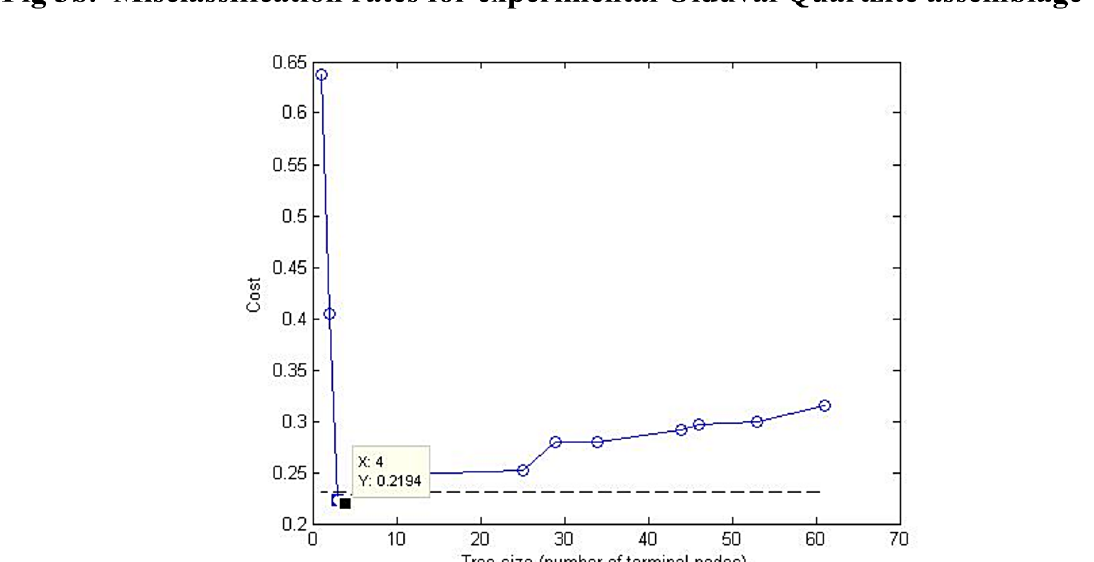
Fig 3. Trimming the classification tree. Each misclassification graph is constructed via random substitution of samples with empirically known classes into the trained algorithm. The X value represents the number of terminal nodes (ends of branches). The smallest value of X for the smallest misclassification value of Y is considered the most economical tree. The classification tree constructed in Fig 4 represents the most economic trees for both raw